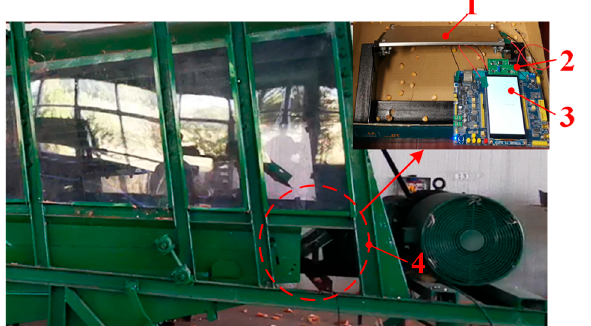
Figure 14. Test device of corn kernel recognition and counting system. ( 1 ) Impact signal acquisition module, ( 2 ) signal processing module, ( 3 ) counting display module, and ( 4 ) corn kernel recognition and counting system.